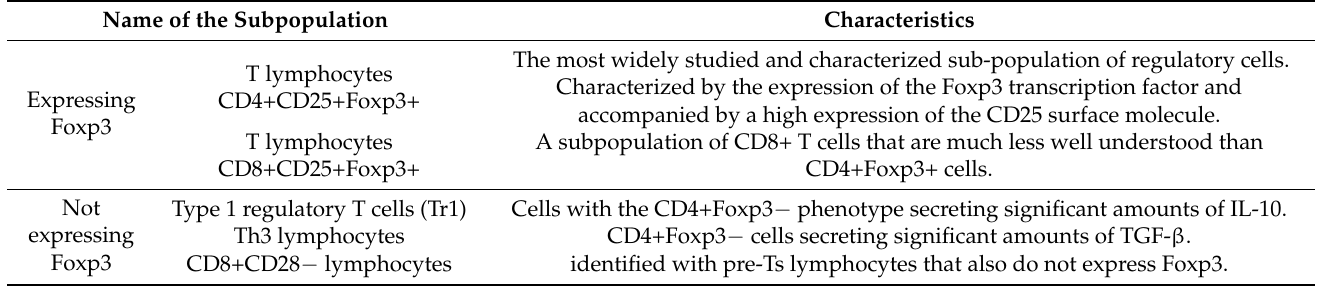
Table 3. Treg lymphocyte subpopulations (based on